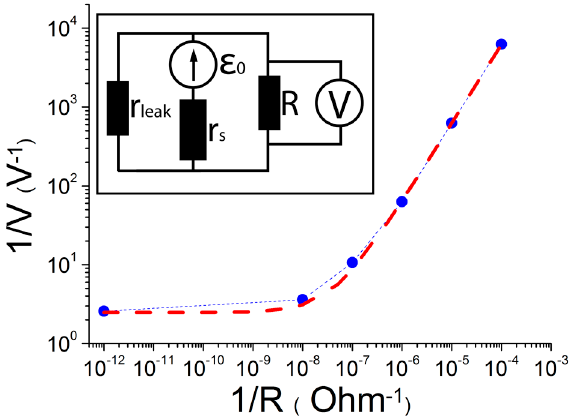
Figure 4. Investigation of load characteristics of the thin-film structure: dependence of reciprocal voltage on the electrodes of the structure as a function of the reciprocal of the external resistance in logarithm scales. The dashed line in this figure shows the approximating function V − 1 (R − 1 ) which is constructed using the model presented on the inset of this figure; (insert)—equivalent circuit.